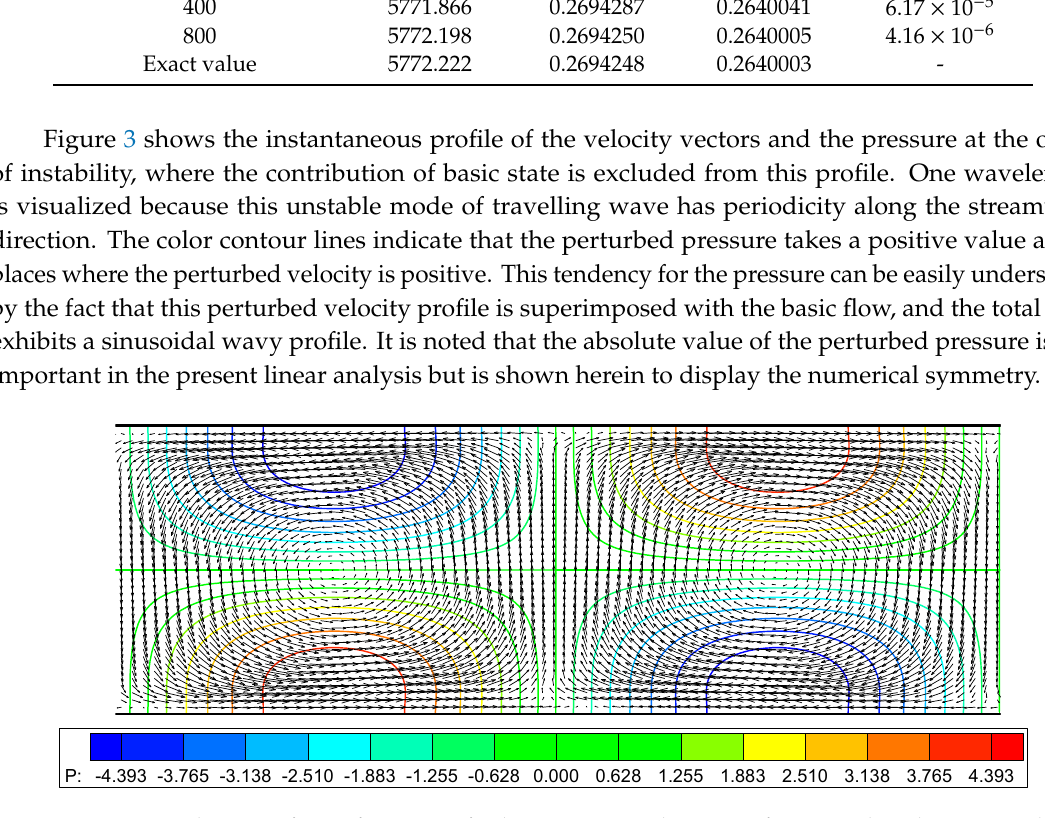
Figure 3. Visualization of eigenfunctions of velocity vector and pressure for a wavelength at a critical point ( Re = 5772, α = 1.02 and C ph = 0.264).